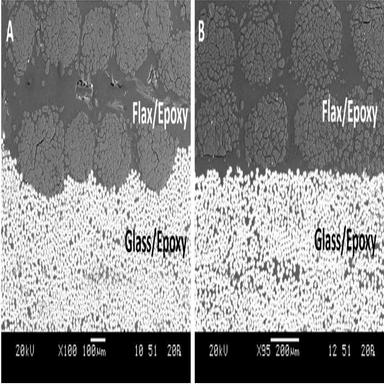
SEM images for interface inspection of the glass/epoxy and flax/epoxy interface at about 100× magnification. (A) Type A configuration, (B) Type B configuration.